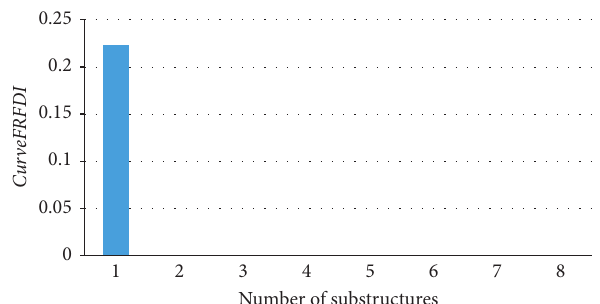
Figure 34: CurveFRFDI values of DIC-measured data for case